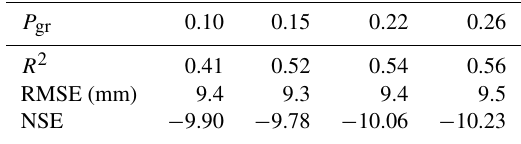
Table 2. R 2 , RMSE, and NSE for total runoff simulations with dif- ferent P gr